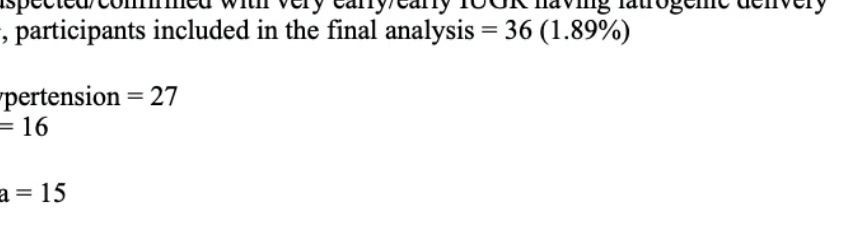
Figure 1. Flow chart